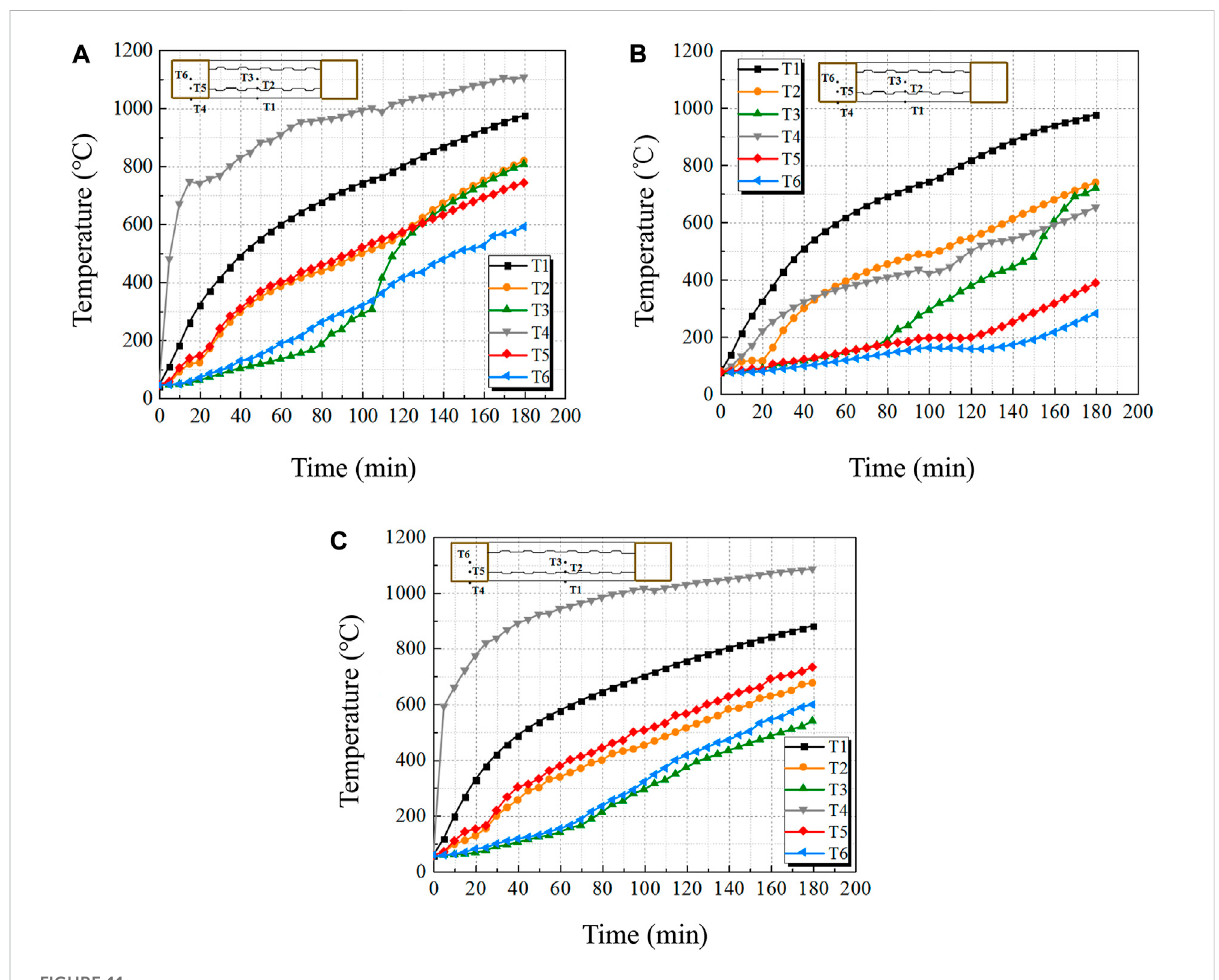
FIGURE 11 Temperature-time curves of (A) SW1; (B) SW2; (C)